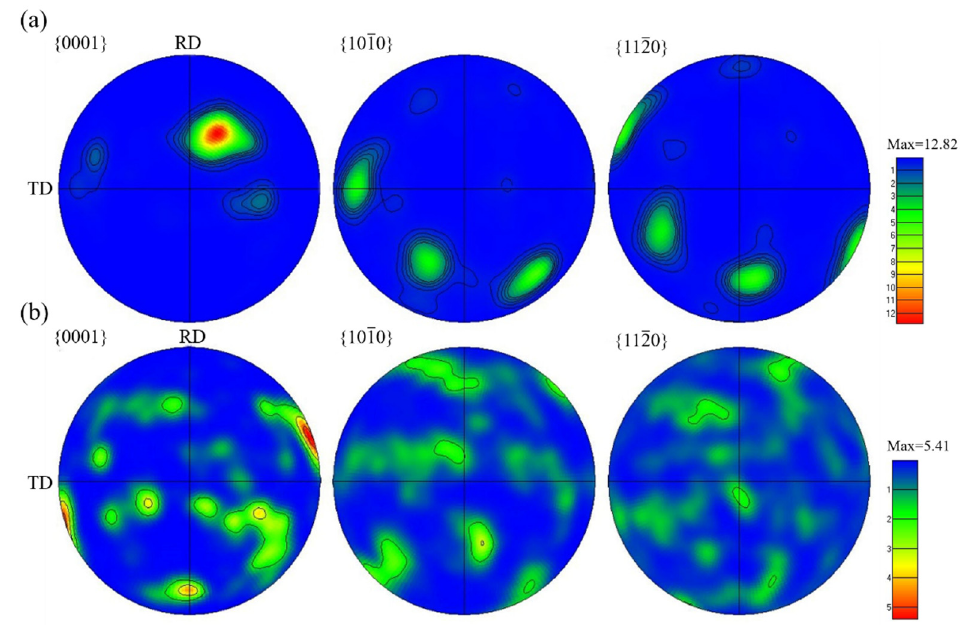
Figure 13. PFs of TC4 alloy sheets: ( a ) Hot-rolled ( b ) 930 °C/15 min, WQ+560 °C/2 h, FC.